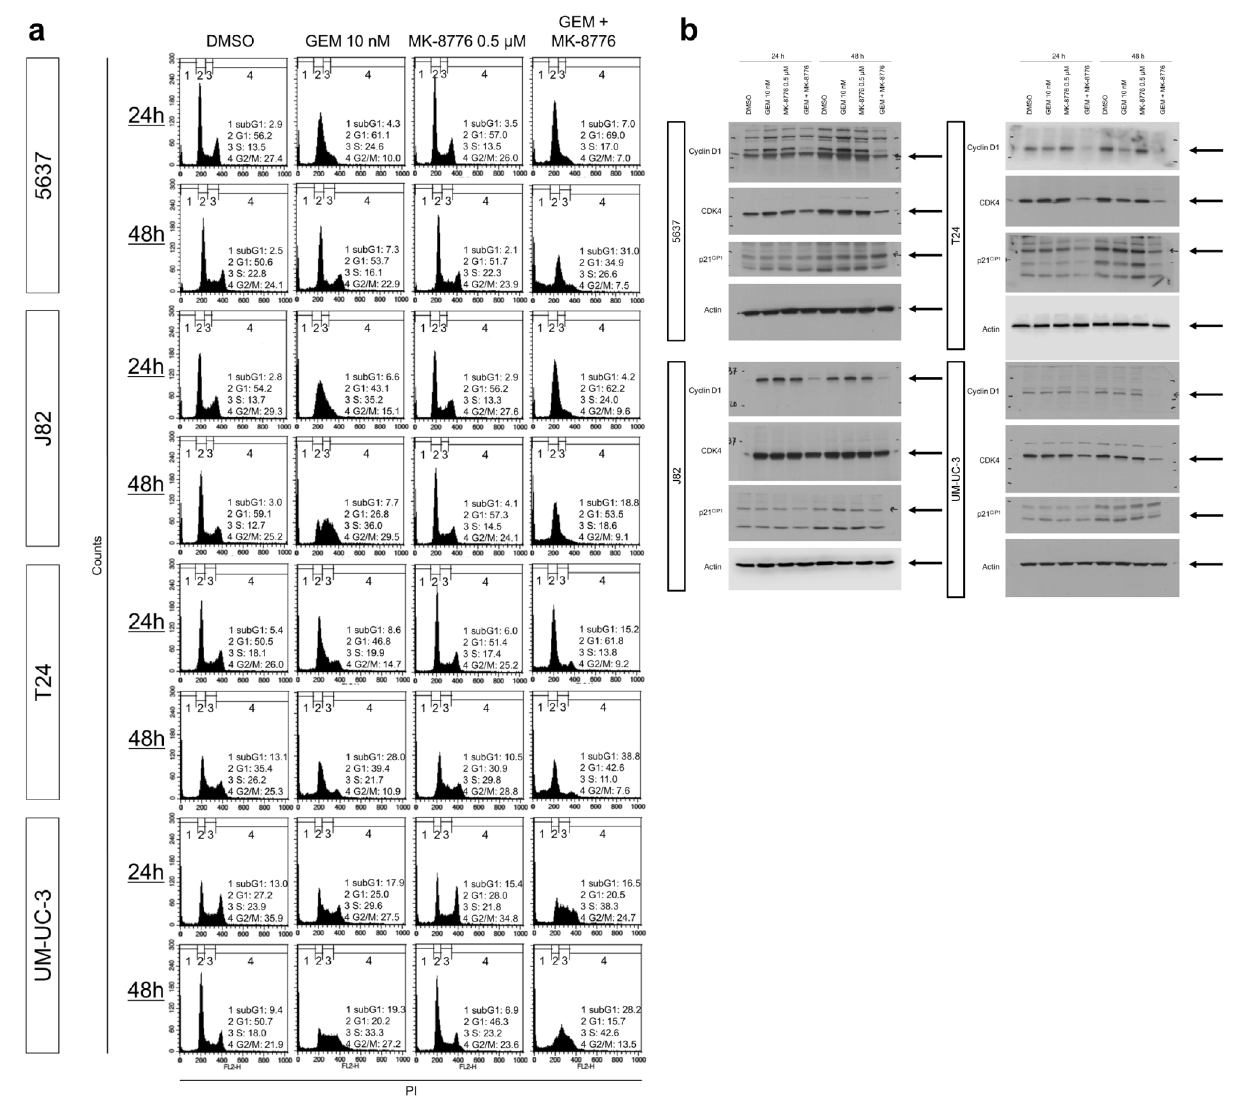
Figure 2. Changes in cell cycle distribution following treatment. ( a ) Flow cytometry analysis of the cell cycle following treatment with gemcitabine (10 nM) and/or MK-8776 (0.5 μM) for 24 or 48 h. DMSO was used as a solvent control. The relative distribution of the fractions is displayed. ( b ) Protein expression following the indicated treatment was evaluated by western blotting. Actin was used as a loading control. A quantification of the signals is illustrated in Fig.